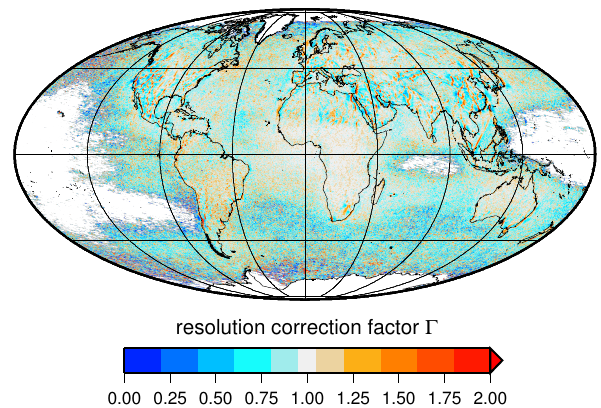
Fig. 5. Annual mean ¯ 0 of the resolution correction factor climatol- Fig. 6 : Annual mean ¯Γ of the resolution correction factor climatology (2003-2011). Pixels ogy (2003–2011). Pixels with a mean VCD SCIA lower than the with a mean VCD SCIA red . res . significantly lower than the instrument precision (estimated to be red . res . 10 14 moleccm − 2 ) have been excluded from the plot. instrument precision (estimated to be 10 14 moleccm − 2 ) have been excluded from the